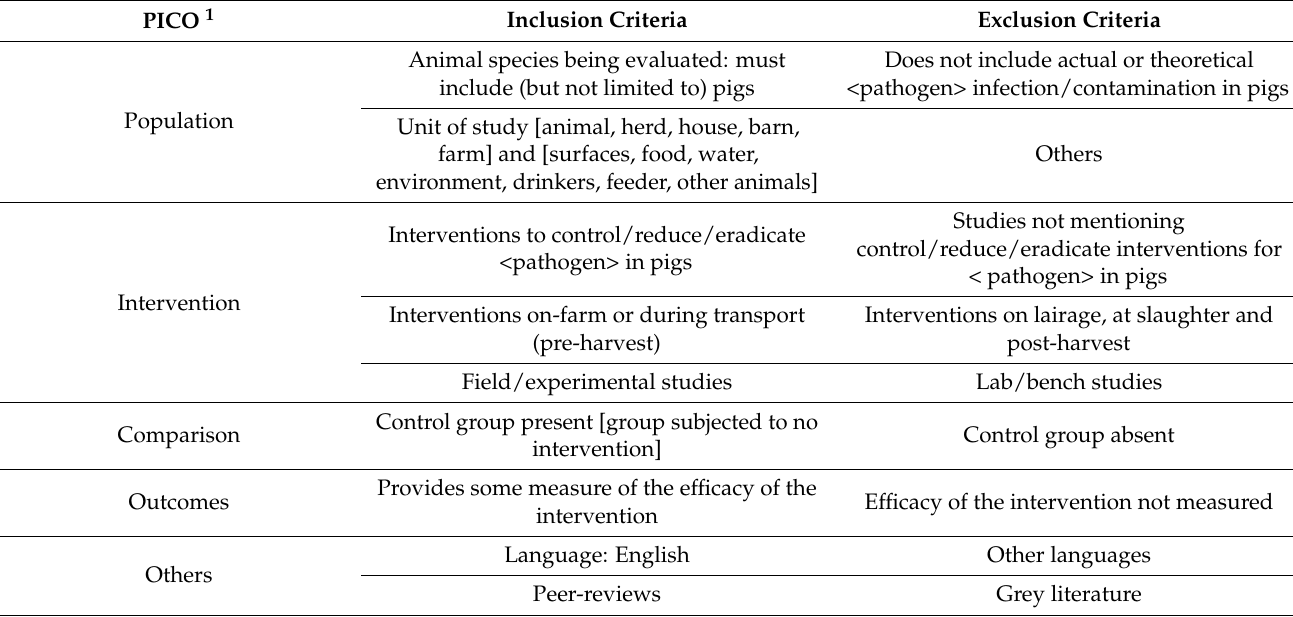
Table 2. Eligibility (inclusion and exclusion) criteria used for the screening of title/abstracts and full texts. Reproduced and adapted from Pessoa et al. [4], where the same set of exclusion and inclusion criteria were used. PICO 1 Inclusion Criteria Exclusion